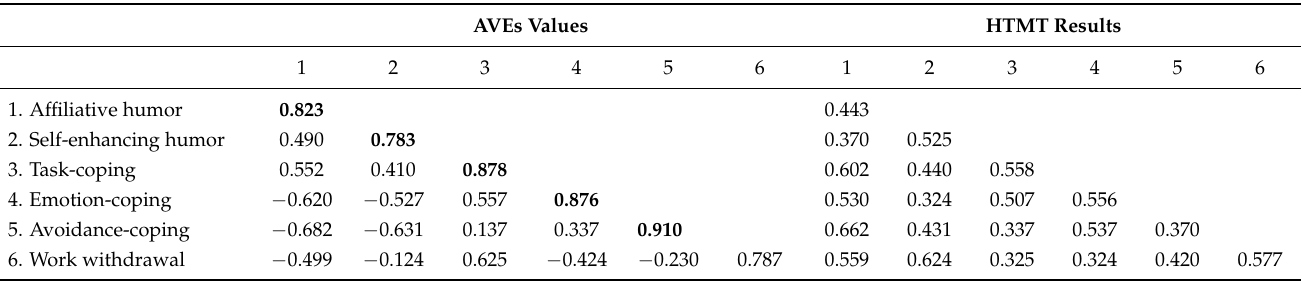
Table 4. Inter-construct correlations, the square root of AVE, and HTMT